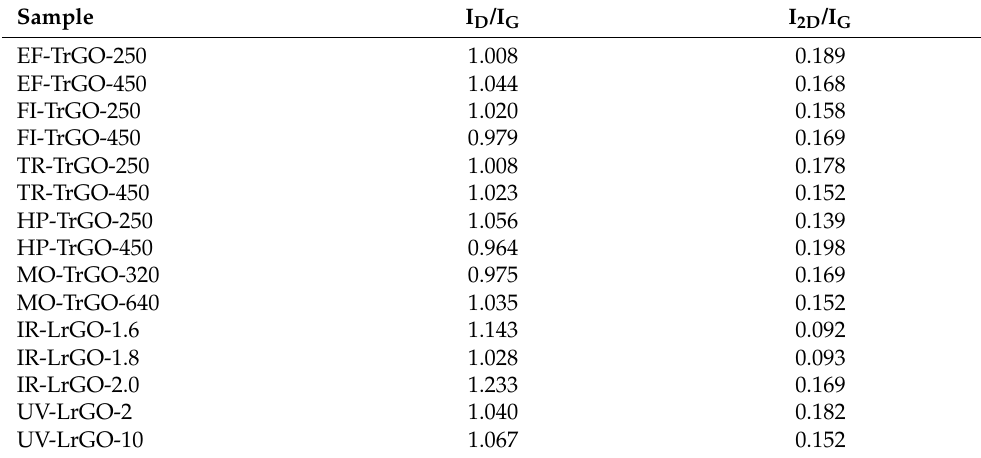
Table 4. I D /I G and I 2D /I G ratio in Raman